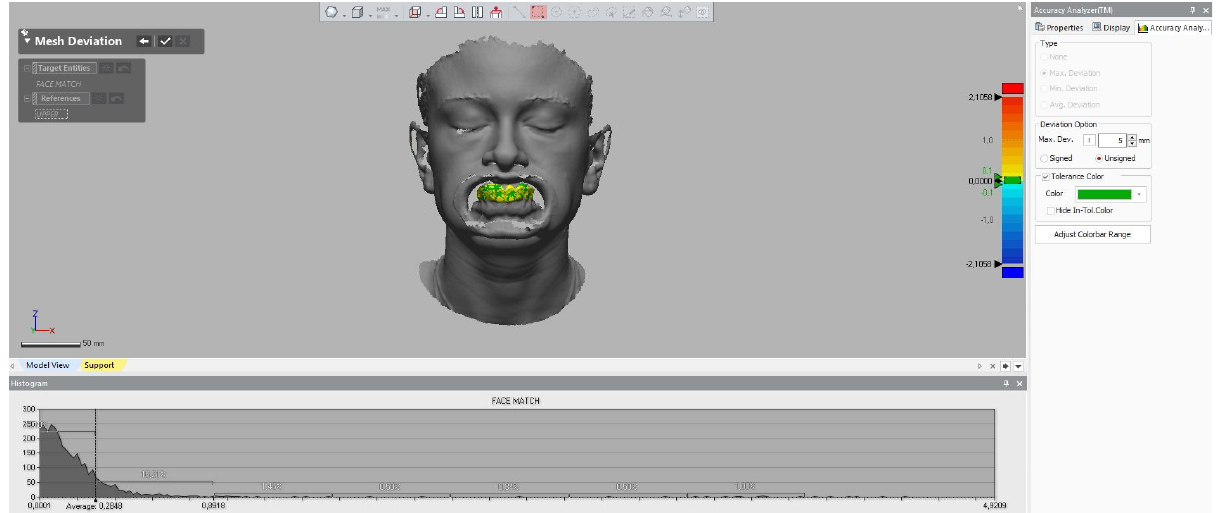
Figure 12. 3D deviation analysis between intraoral scan and face scan with lip-and-cheek retractor. RGB-colored scale bar (millimeters) is reported on the right. Histogram chart is reported at the bottom.